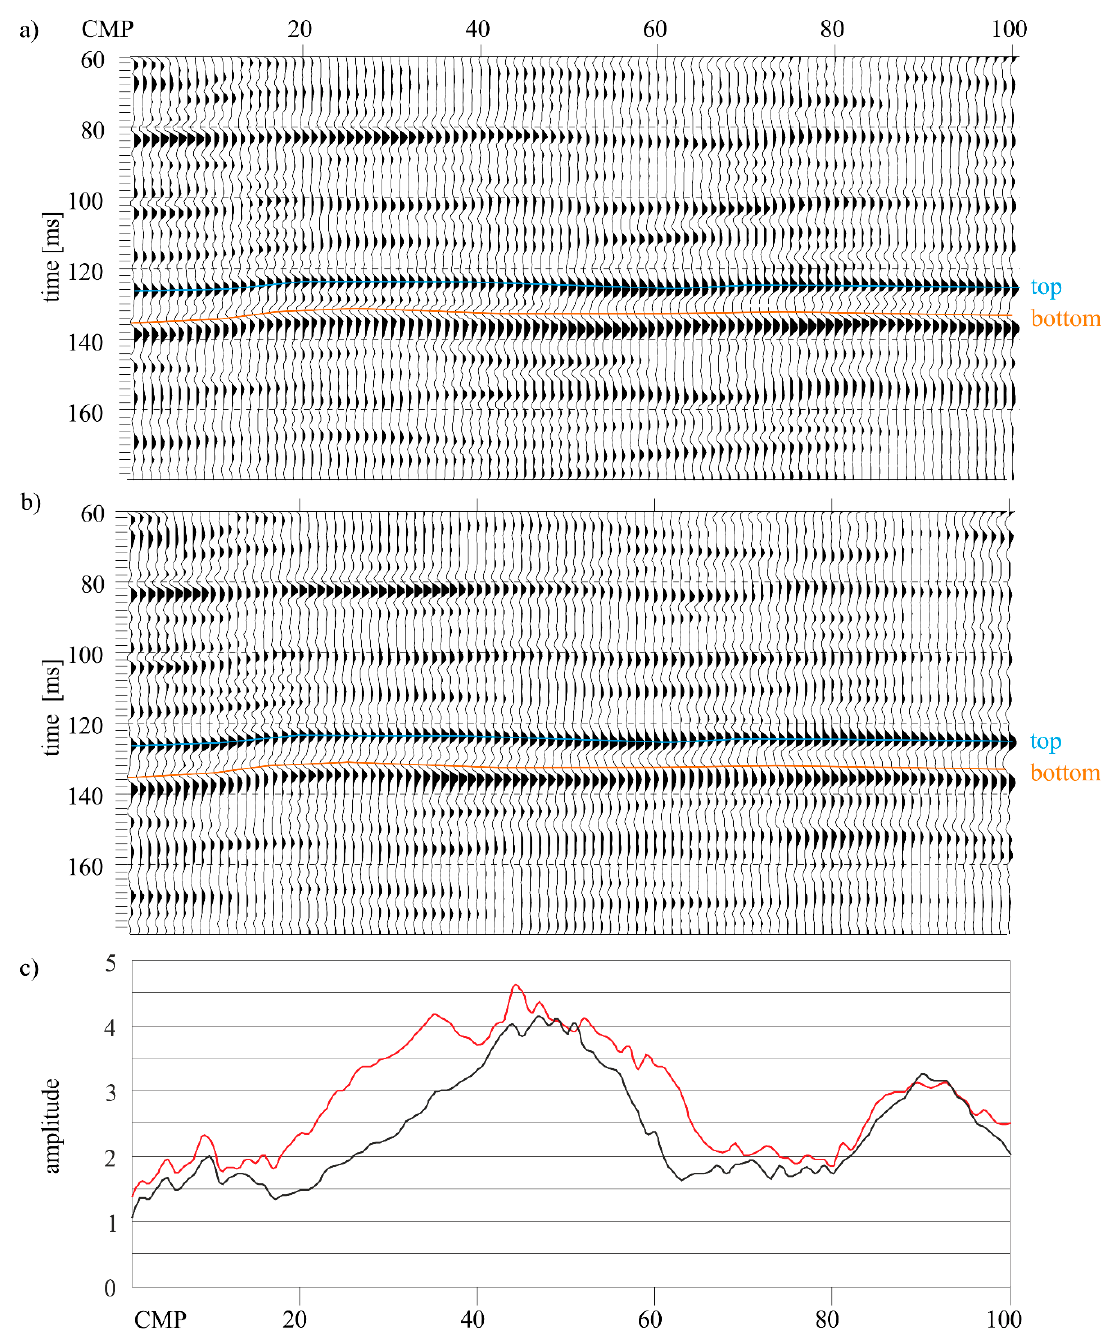
Figure 7. Fragment of a real seismic cross section showing the top and the bottom of sulphur deposit acquired by stacking different offset ranges. ( a ) 40–155 m offset range; ( b ) 40–235 m offset range; ( c ) graph of amplitude reflected from the top of the deposit, where the red line corresponds to offsets of 40–155 m and black line to offsets of 40–235 m.